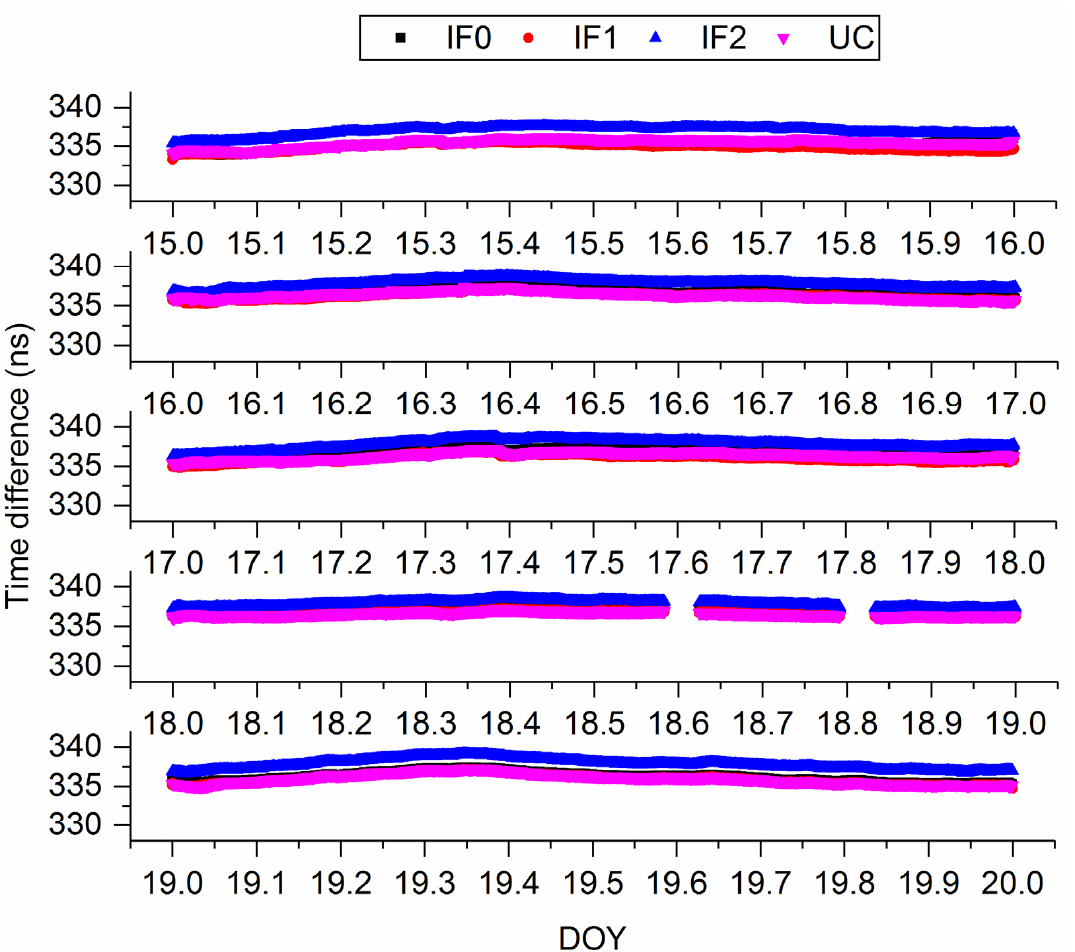
Figure 3. Comparison of time difference of XIA3-BRCH obtained from different models.